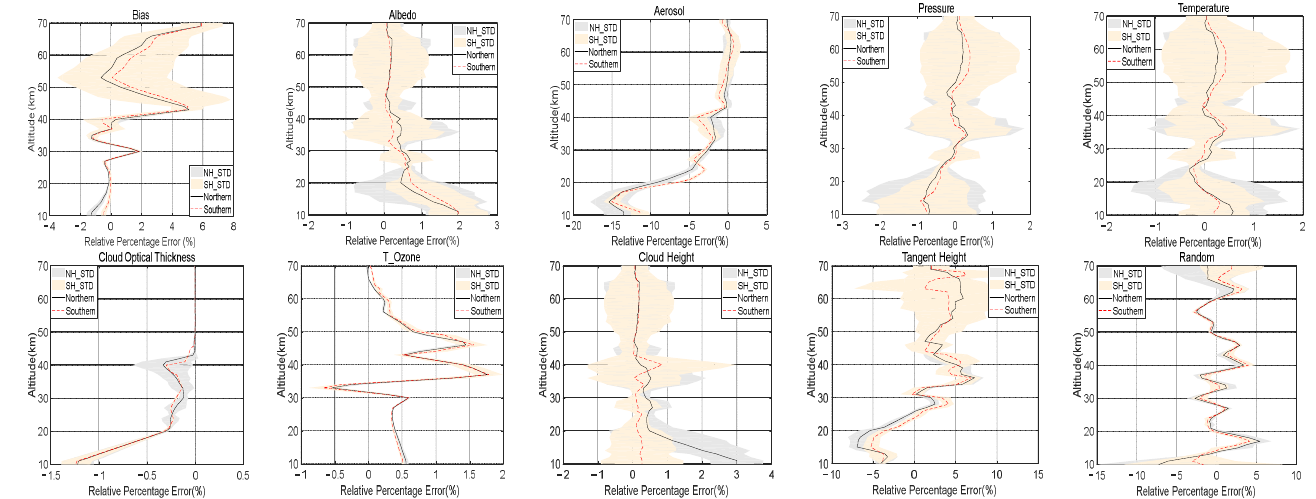
Figure 12. Average error profiles from an altitude of 10 to 70 km for the NH and SH. The uncertainties for each parameter were +0.1 for albedo, −50% for a priori ozone profile scaling, −5% for pressure, −5 K for temperature, and +200 m for tangent height, a comparison between 223 and 243 K experimental cross-section values, AS clouds, −50% for cloud optical thickness scaling, and no aerosols for atmosphere. Standard deviations are shown in the shaded regions.